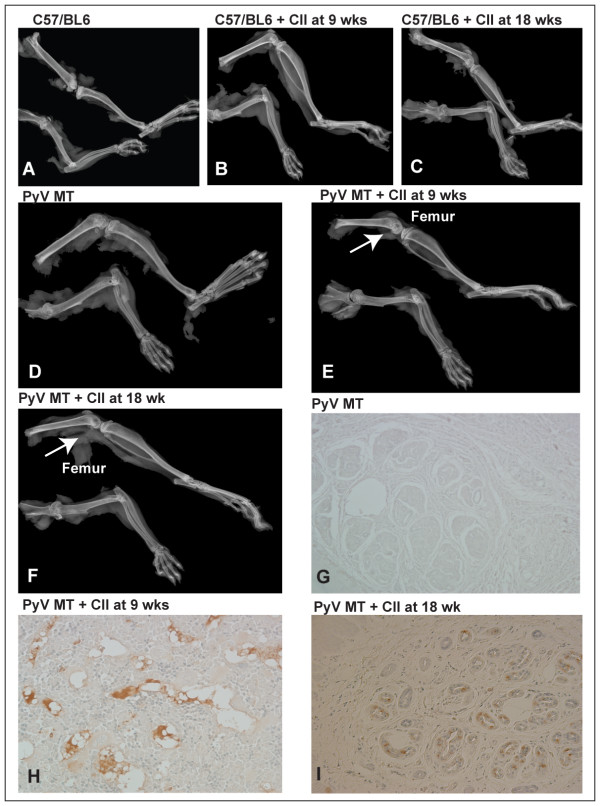
Metastatic bone lesions accompanied with increased expression of Pancytokeratin in the bones of arthritic PyV MT mice. A-F: Representative x-ray images of bones. A-D: Bones from C57/BL6 mice injected with CII at 9 and 18 wks and PyV MT mice with no metastatic lesions; E and F: Bones from PyV MT + CII at 9 wks and 18 wks respectively (shows distinct severe osteolytic bone lesion in distal femur as indicated by the arrow). N = 8 mice from each group were examined using the x-ray imaging. G-I: Pancytokeratin positive staining observed in the bones of arthritic PyV MT mice. Brown staining represents positive staining. The images were taken at 400× magnification. Representative of n = 10 mice is shown.